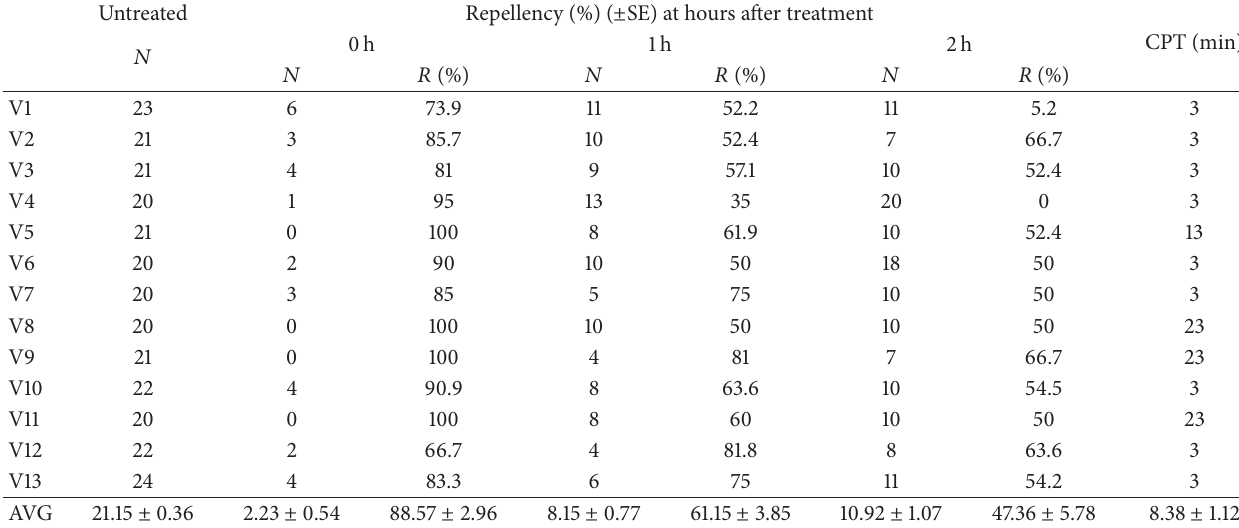
Table 3: Repellency and CPT of 5% fennel oil against Aedes albopictus in laboratory test.